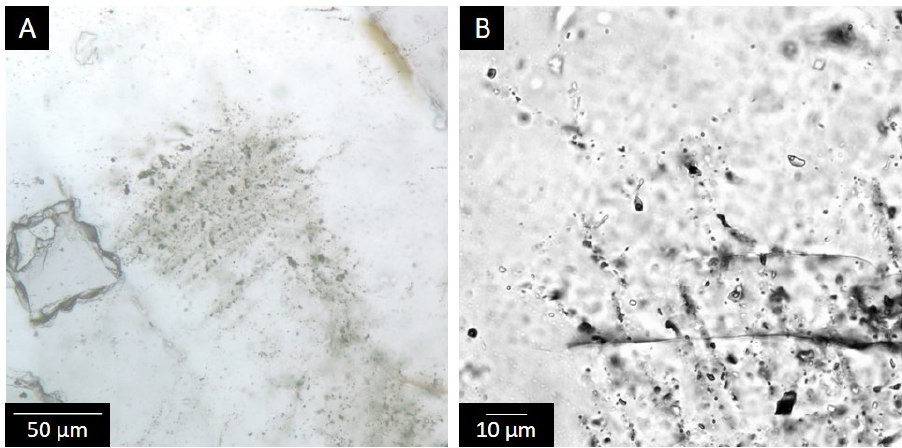
Figure 8. Fluid inclusion petrography. ( A ): Microphotograph of the cloudy core of a comb quartz crystal of vein type 1. ( B ): Typology of fluid inclusions inside a Fluid Inclusion Assemblage. Experiments were performed on the thin sections used for petrographic